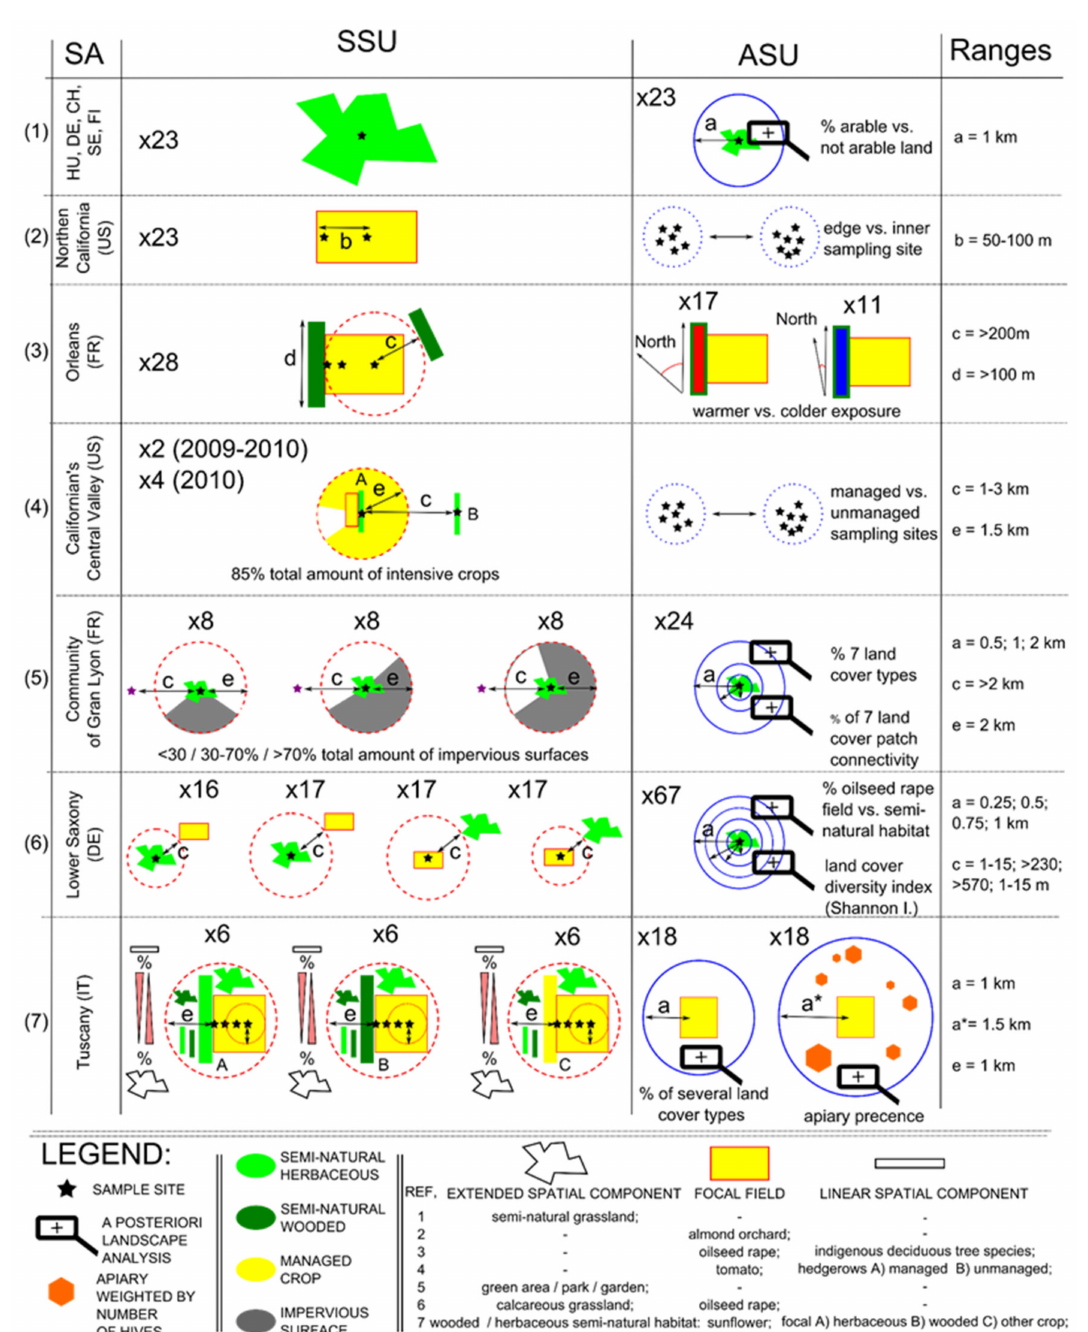
Figure 2. The landscape ecology approach. Innovation in landscape ecology enables generalization and introduces new definitions for methodological approaches (Section 4). We grouped them according to three spatial units: the study area (SA), the specific spatial unit (SSU), the advanced spatial unit (ASU). Level of detail can vary but can be resumed and compared according to spatial context. The examples were inspired by ( 1 ) [26]; ( 2 ) [14]; ( 3 ) [21]; ( 4 ) [32]; ( 5 ) [30]; ( 6 ) [13]; ( 7 )